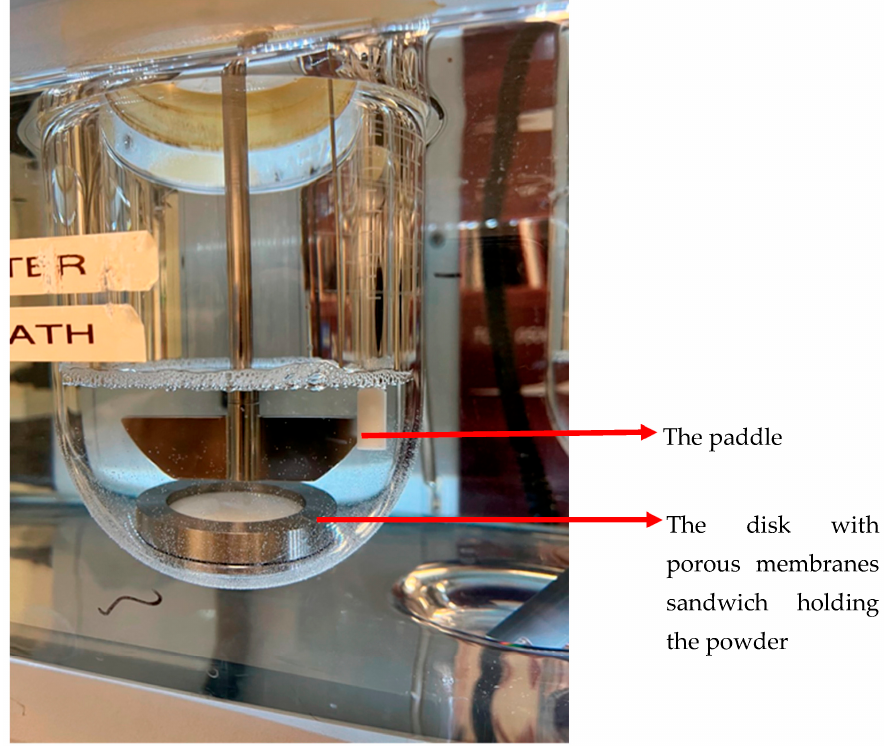
Figure 3. Paddle dissolution apparatus with insert holder and polycarbonate fi lter.